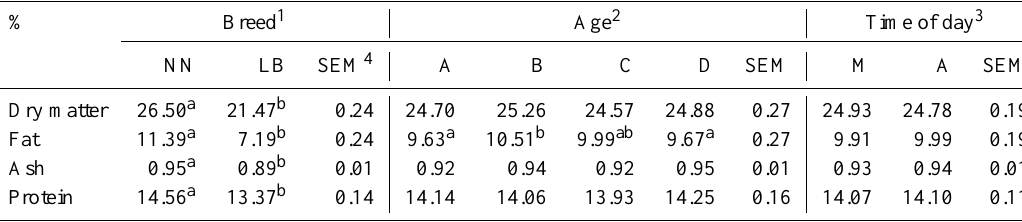
Table 2. Effect of breed, age and time of sampling on proximate composition of whole eggs (least square means). %